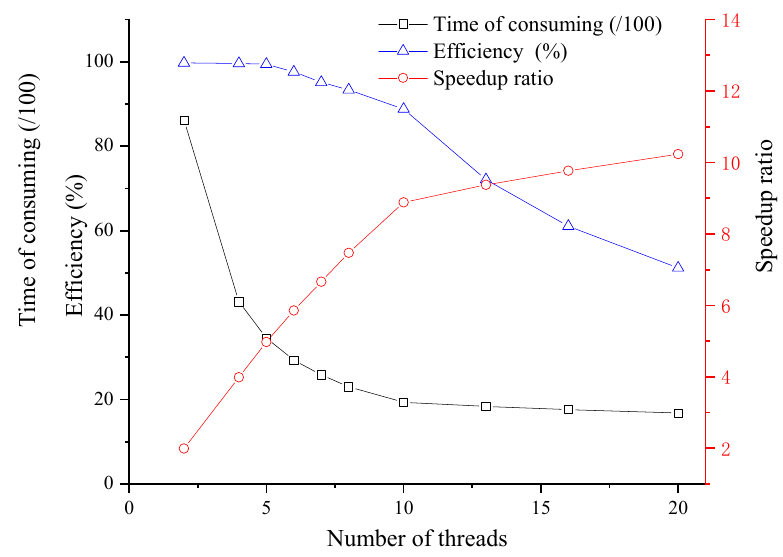
Figure 10. CPU-OpenMP model parallel computing performances.